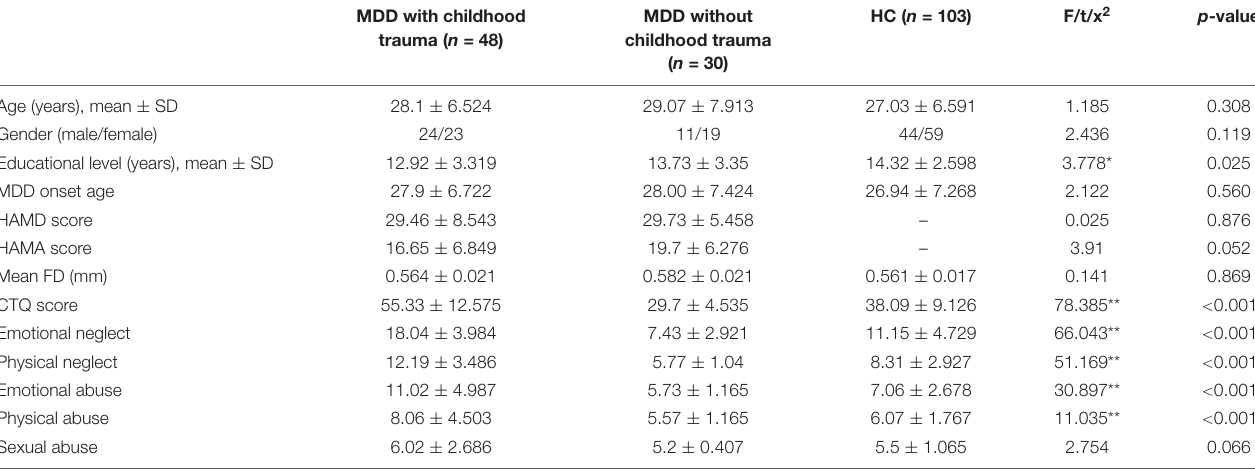
TABLE 1 | Demographic and clinical scale scores of MDD with childhood trauma, MDD without childhood trauma, and HC